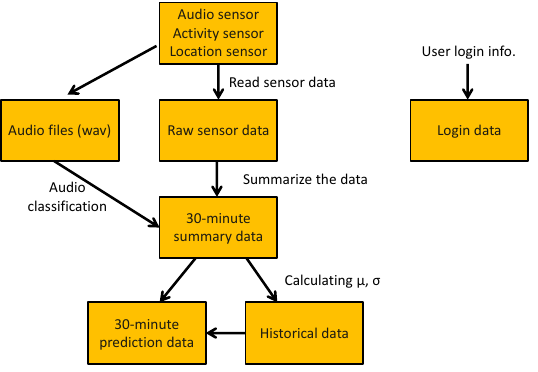
Figure 5. Diagram to store sensor data on the mobile